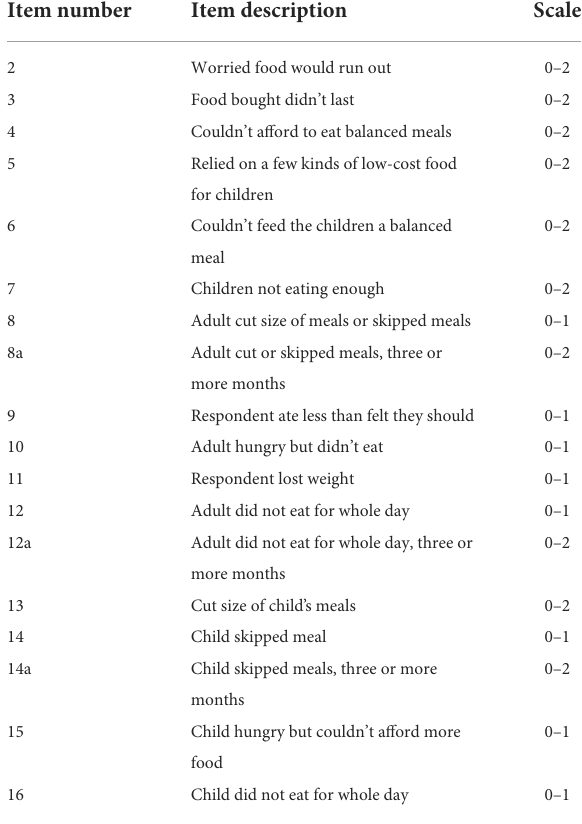
TABLE 2 Questions included in the food security